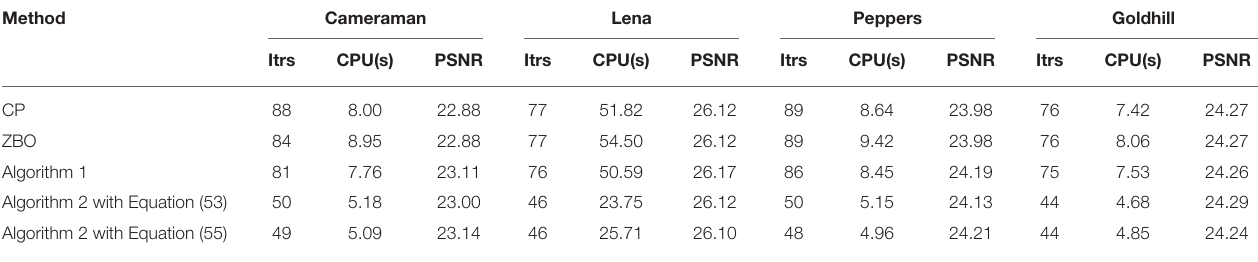
Algorithm 1 Algorithm 2 with Equation (53) Algorithm 2 with Equation